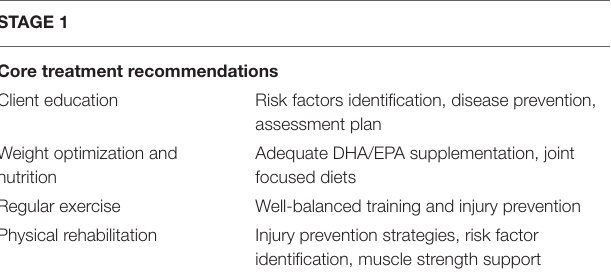
TABLE 1 | Summarized core treatment recommendations for COAST Stage 1. STAGE